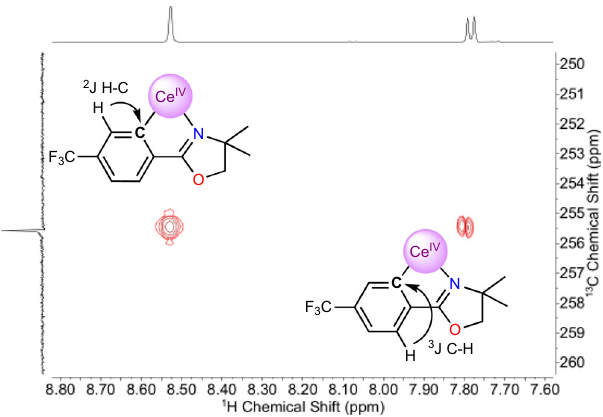
Fig. 5 Identi fi cation of the unusual 13 C resonance. A portion of the HMBC spectrum showing the long-range C-H coupling to the 13 C resonance at 255.6 ppm. An interpretation of the spectrum is inlaid, indicating that the signal at 255.6ppm corresponds to the ipso -carbon.